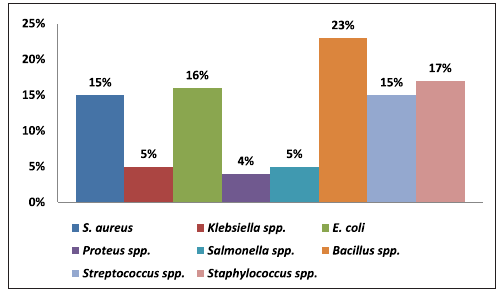
Fig. 3. Bar chart of percentage distribution of isolated bacterial species.